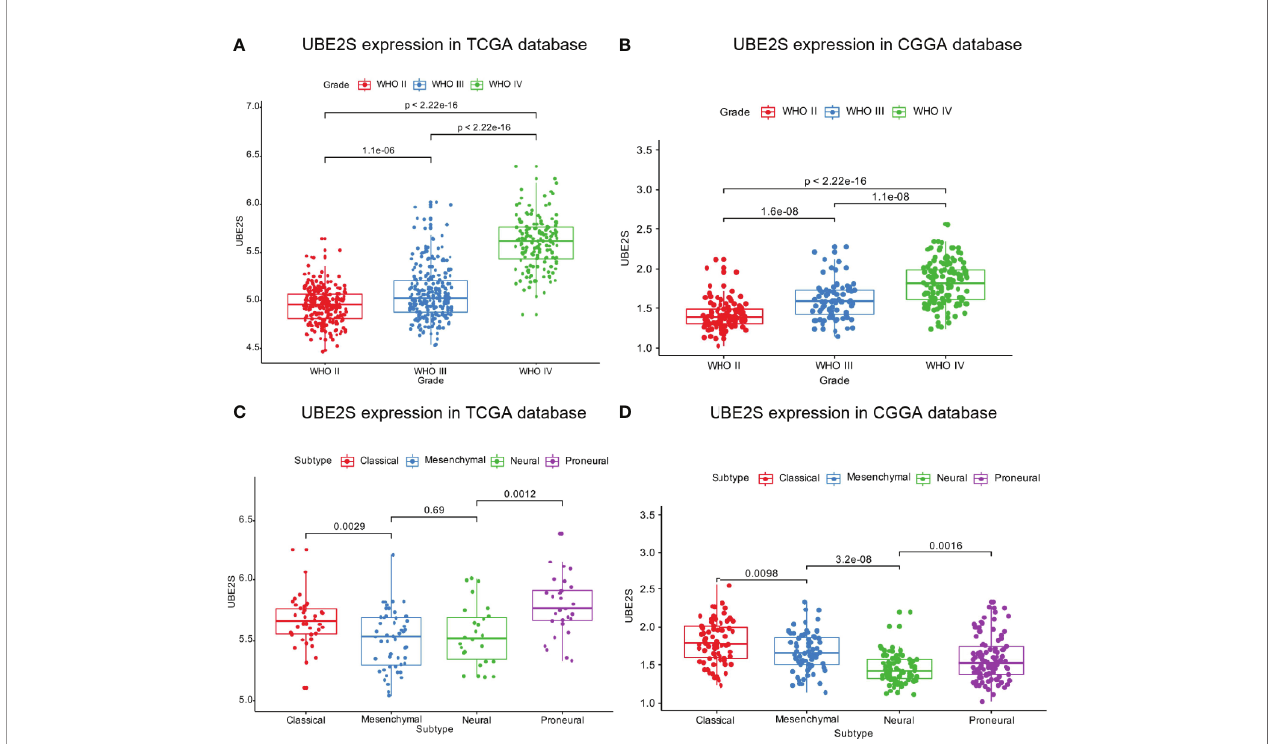
FIGURE 1 | UBE2S was signi fi cantly upregulated in glioblastoma. (A, B) UBE2S expression level was signi fi cantly high in glioblastoma (WHO IV) samples in TCGA and CGGA data set. (C, D) UBE2S expression pattern in different molecular subtypes in TCGA and CGGA data set. P is based on Kruskal-Wallis